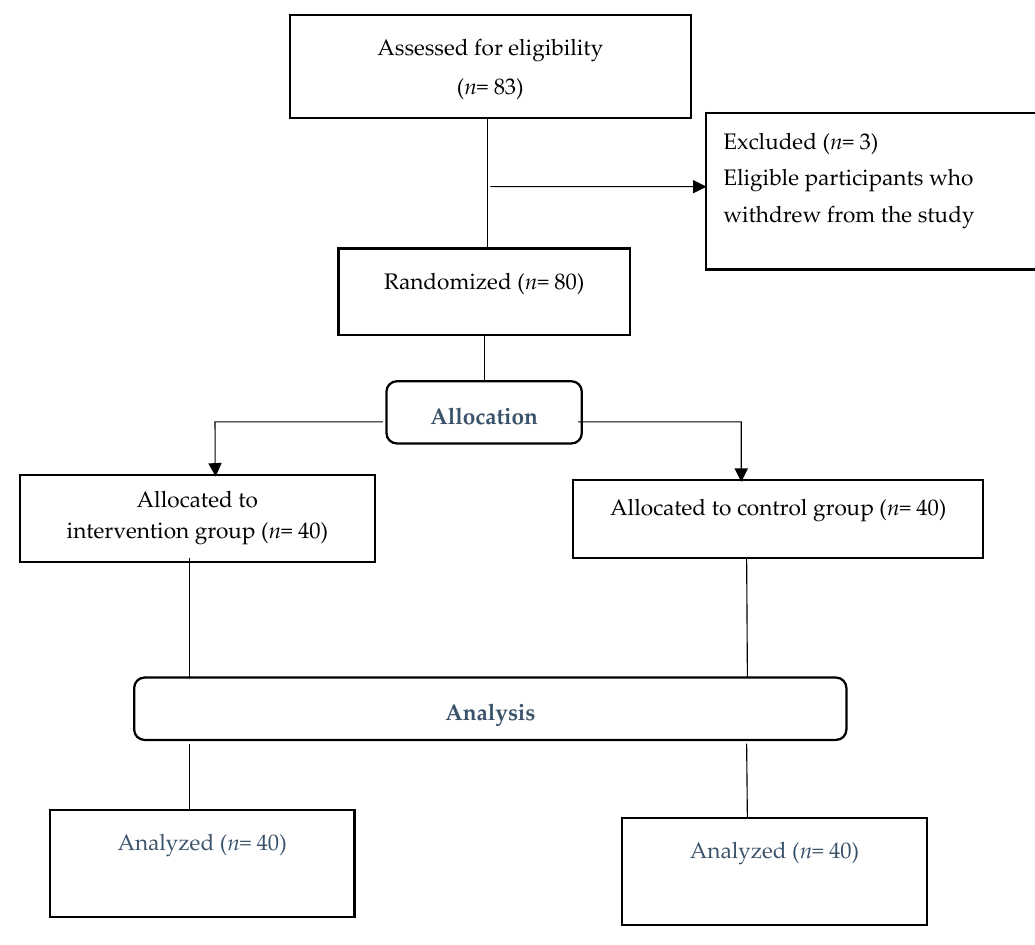
Figure 1. Flowchart of subject progress.